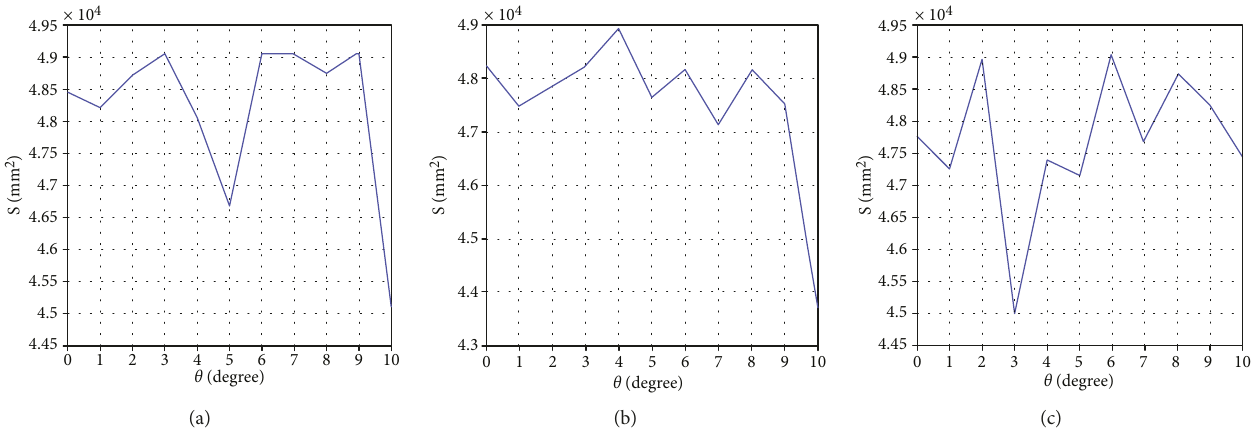
Figure 7: (a) Relation between the de fl ection angle θ and the e ff ective adhesion area S of the leg 2. (b) Relation between the de fl ection angle θ and the e ff ective adhesion area S of the leg 4. (c) Relation between the de fl ection angle θ and the e ff ective adhesion area S of the leg 6.